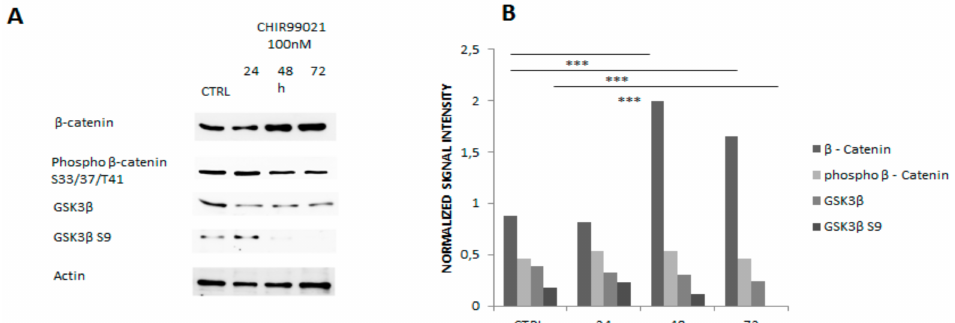
Figure 3. ( A ) 40 ug of MLO-Y4 protein extracts were separated in SDS-PAGE and evaluated by western blot for the indicated antibodies. ( B ) Optical density relative to three different experiments was measured and represented in the bars chart. *** p < 0.05.